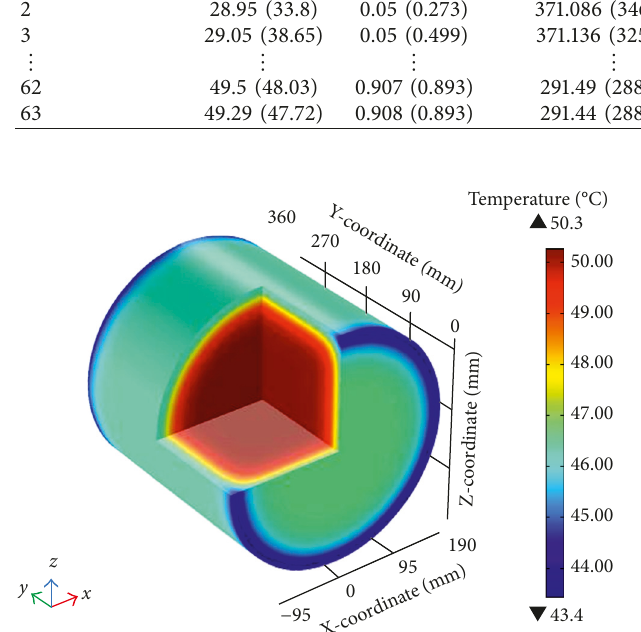
Figure 6: Temperature distribution of concrete specimen at the 28th day.